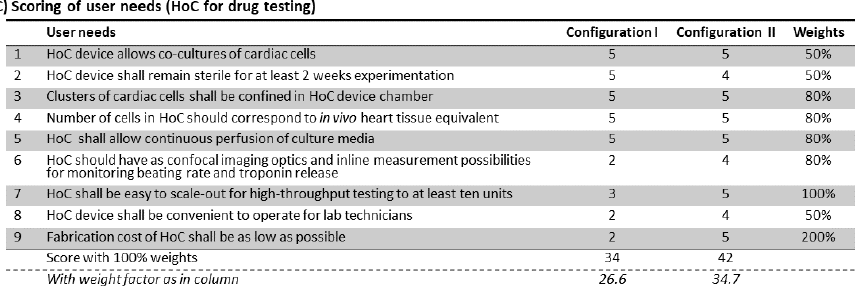
Figure 10. A blueprint of a Heart-on-Chip device designed based on the HE-map conceptual analysis